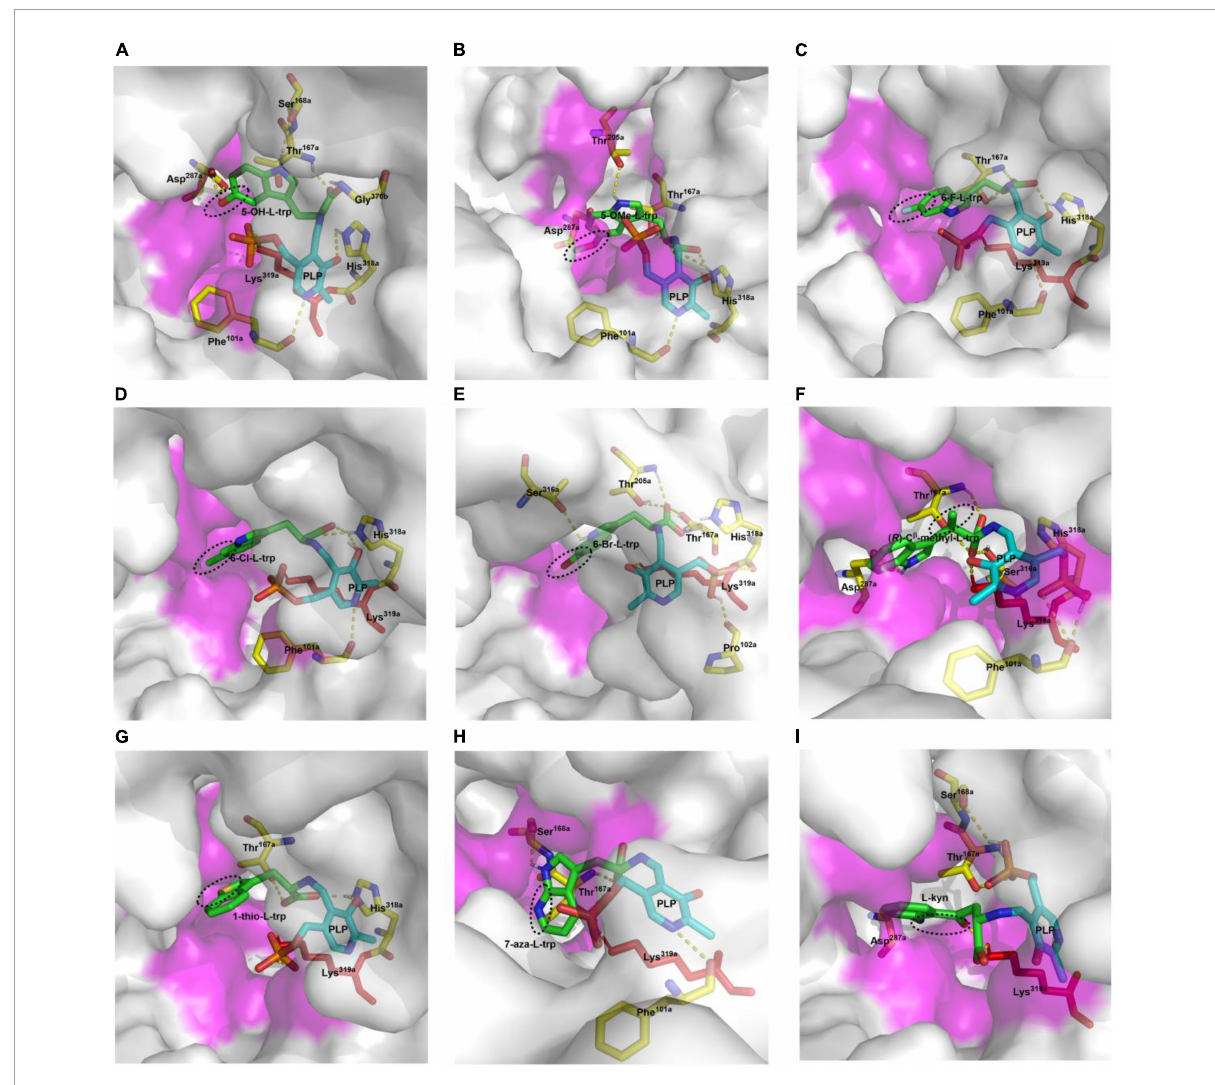
FIGURE12 Molecular docking of CaTDC3 with different L-tryptophan analogs. The docked substrates are 5-hydroxy-L-tryptophan (A) , 5-methoxy-L-tryptophan (B) , 6-fluoro-L-tryptophan (C) , 6-chloro-L-tryptophan (D) , 6-bromo-L-tryptophan (E) , ( R )-C β -methyl-L-tryptophan (F) , 1-thio-L-tryptophan (G) , 7-aza-L-tryptophan (H) , and L-kynurenine (I) . The amino acid residues from one monomer to form the catalytically active domain were highlighted as Phe 101a , Thr 167a , Ser 168a , Asp 287a , His 318a , and Lys 319a . The other amino acid residues within 5 angstrom around L-tryptophan from another monomer were shown in